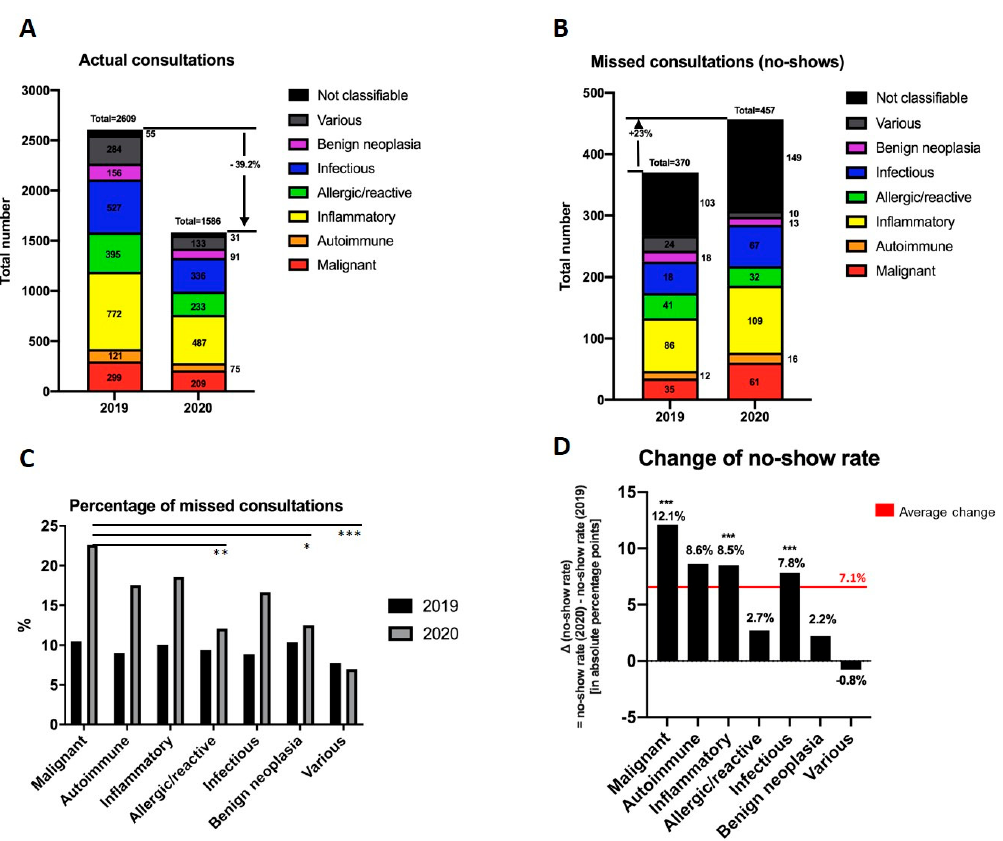
Figure 3. Distribution of diagnosis clusters in the polyclinic in March and April 2019 and 2020 within the group of actual and missed consultations. ( A , B ) Absolute numbers: ( A ) Actual consultations; ( B ) missed consultations (no-shows), consisting of malignant (red), autoimmune (orange), inflammatory (yellow), allergic / reactive (green), infectious (blue), various (gray), not classifiable (black) diseases, and benign neoplasia (violet). ( C , D ) Relative proportion of no-shows to total consultations: ( C ) Percentage of missed consultations in 2019 (black) and 2020 (gray); ( D ) change of no-show rate 2020 compared to 2019 indicated in absolute percentage points. Average change indicated in red. Significance level was defined as p < 0.05 (*), p < 0.01 (**), and p < 0.001